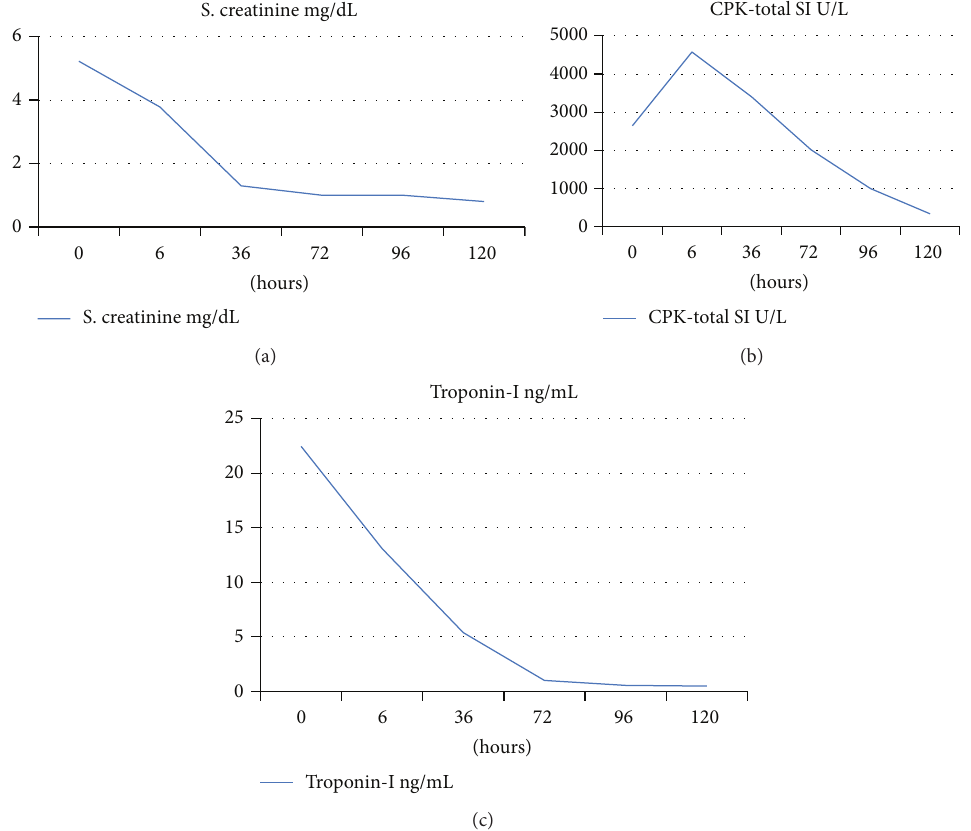
Figure 1: Line graph illustrating laboratory results of creatinine (a), CPK (b), and troponin (c) during in-hospital stay.